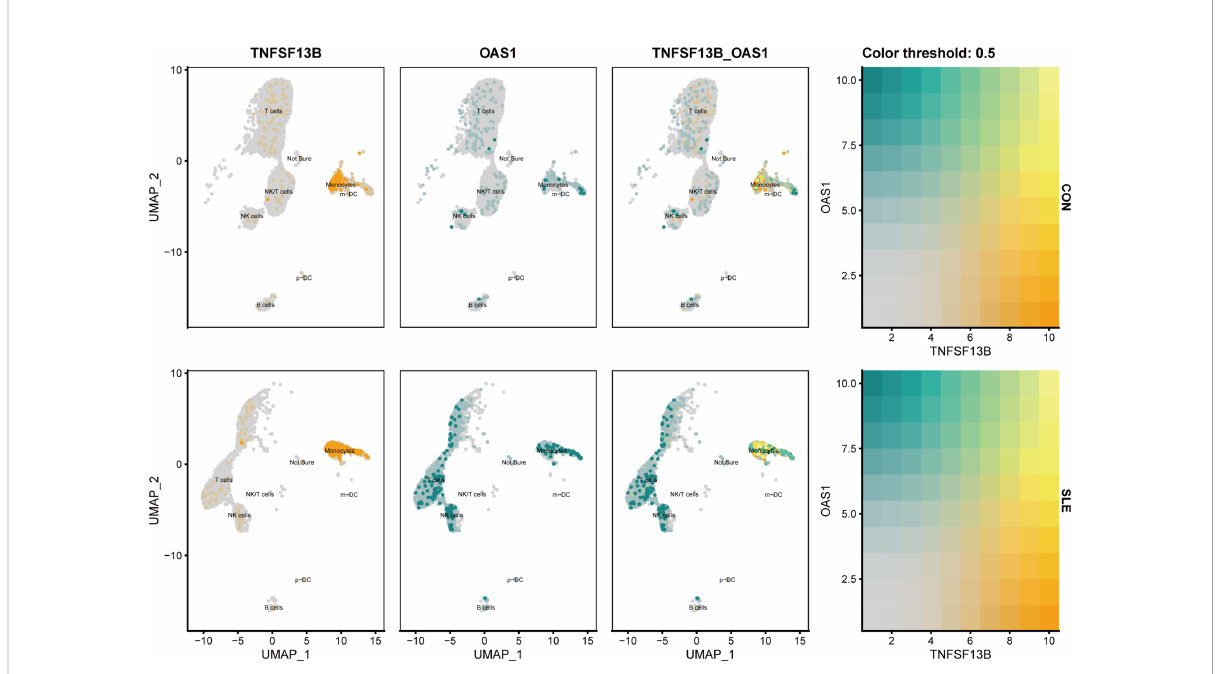
FIGURE 11 UMAP visualization of TNFSF13B and OAS1 expression in controls and SLE patients in GSE135779. Yellow dots indicated TNFSF13B expression, and cyan dots indicated